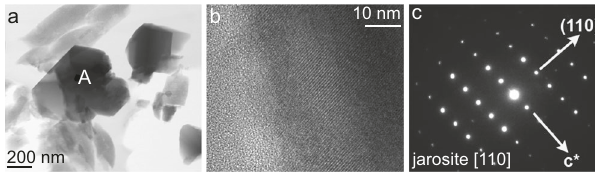
Fig. 4 STEM on TALDICE dust. a A STEM image of dust particles. b A selected area of electron diffraction (SAED) pattern from the crystal labelled A in a . c The SAED pattern with highlighted [ − 110] zone axis of